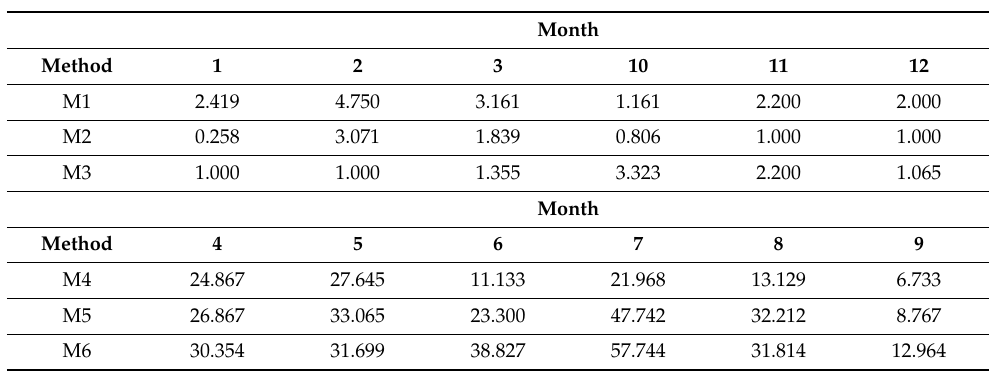
Table 5. E-flow calculation results for Huangchuan River (m 3 /s).